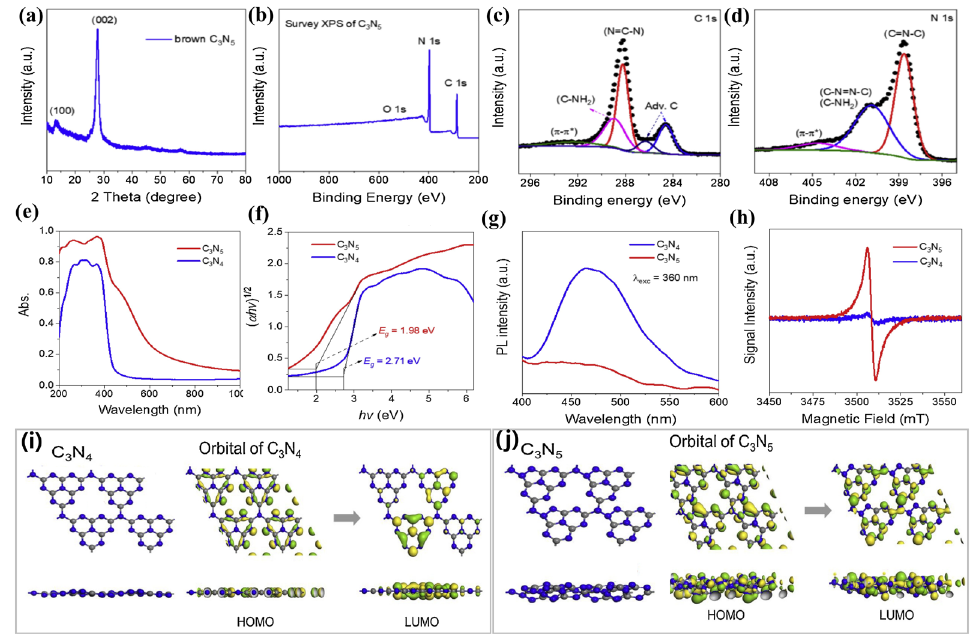
Figure 3. The characterization of g-C 3 N 5 : ( a ) XRD pattern; ( b ) XPS survey; ( c ) high-resolution C1s spectra; ( d ) high-resolution N1s XPS spectra for g-C 3 N 5 ; ( e ) UV–vis DRS; ( f ) Tauc’s plot; ( g ) PL spectra; ( h ) ESR spectra for g-C 3 N 5 and g-C 3 N 4 ; ( i , j ) The orbitals for g-C 3 N 4 and g-C 3 N 5 . Adapted with permission from [28]. Copyright Elsevier B.V., 2021.